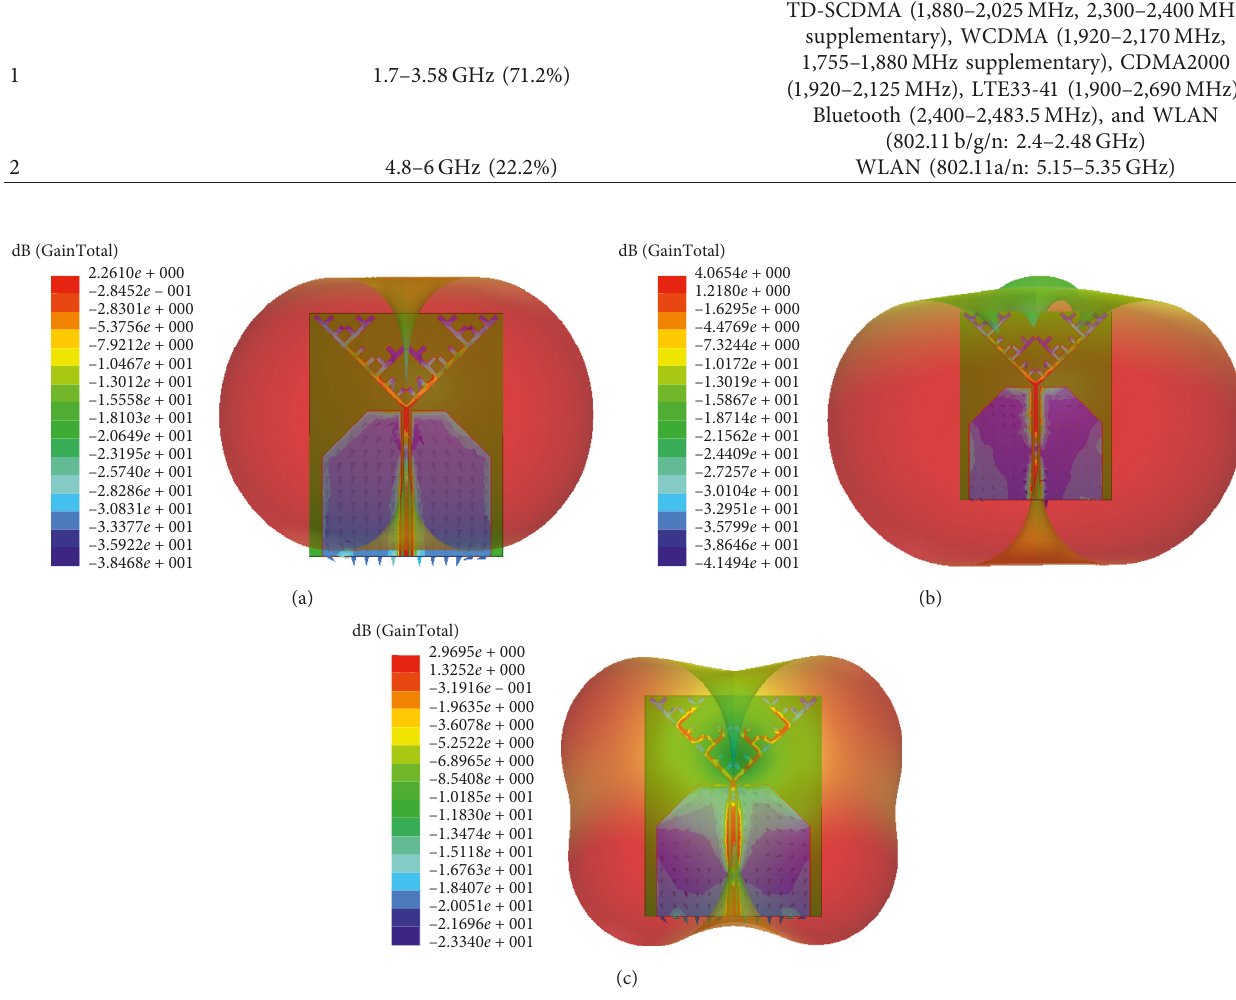
Figure 6: 3D radiation patterns. (a) 2GHz. (b) 3.25GHz. (c) 5.1 GHz.